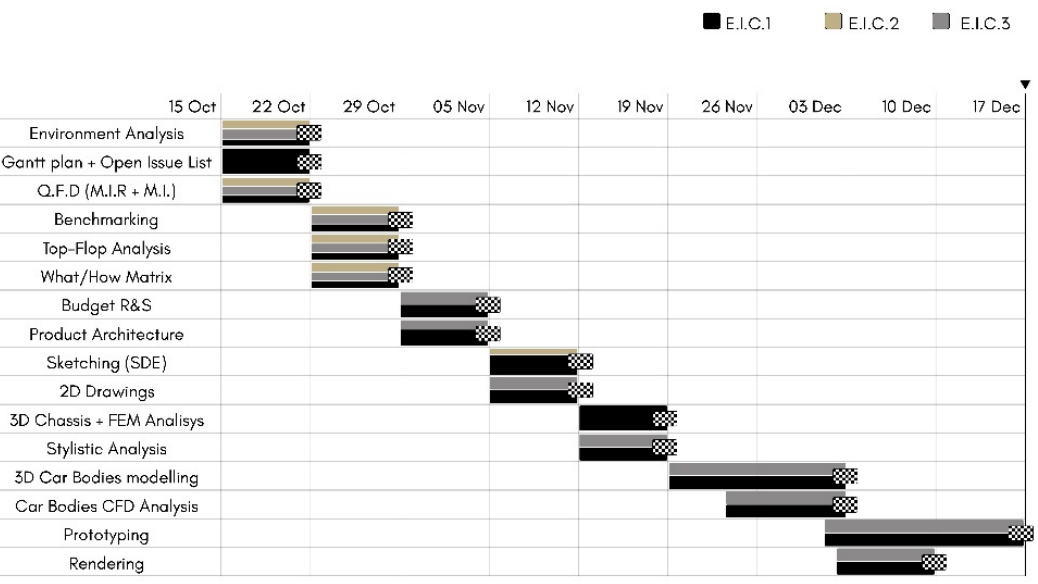
Figure 12. Gantt Figure 12. Gantt Plan.